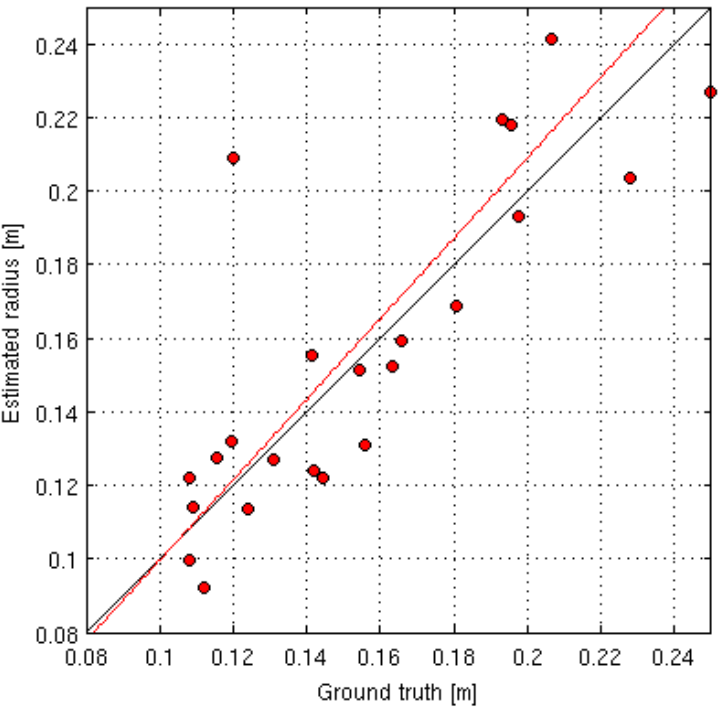
Figure 16. Estimated diameter vs . ground truth on Plots 165, 167 and 343. The red line is the regression line. The black line indicates